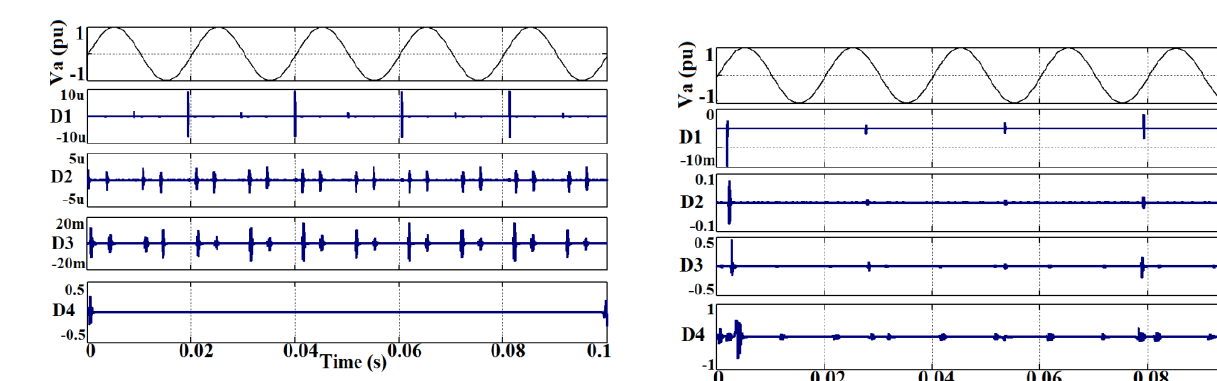
Figure 13. DWT details for Diode load.